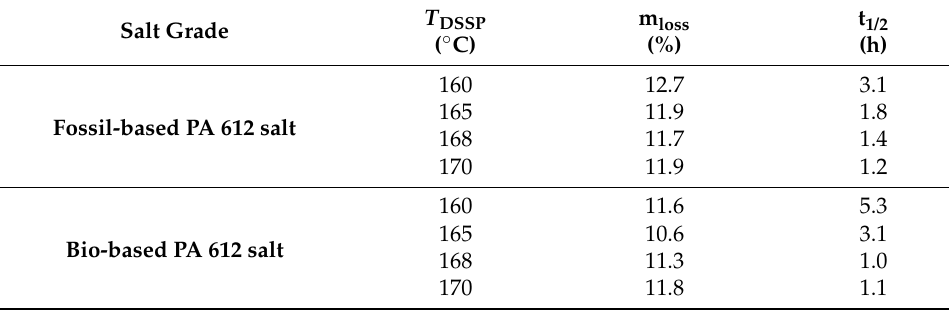
Table 4. Mass loss and t 1/2 for the DSSP of fossil-based and bio-based PA 612 salt. Salt